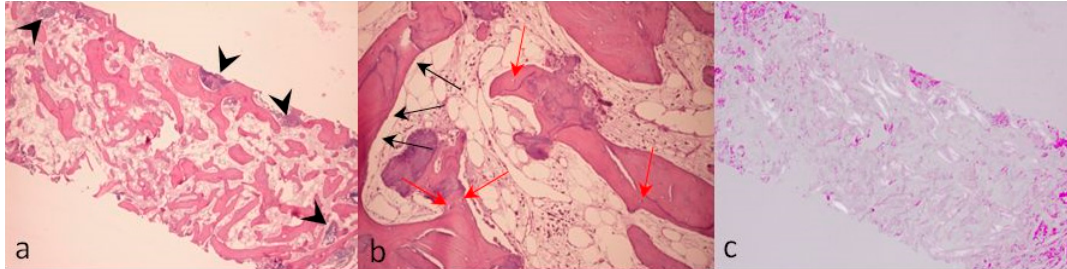
Figure 12. Bone biopsies collected five months after the GBR procedure were stained with haematoxylin and eosin (H&E) and examined by light microscopy ( a , 3.5×; b , 10×) and under polarized light ( c , 3.5×). Black arrows in subfigure a indicate the residual graft material. Black and red arrows in subfigure b respectively show osteoblasts and osteocytes within the newly formed bone. No osteoclasts were detected in the slides being analyzed.